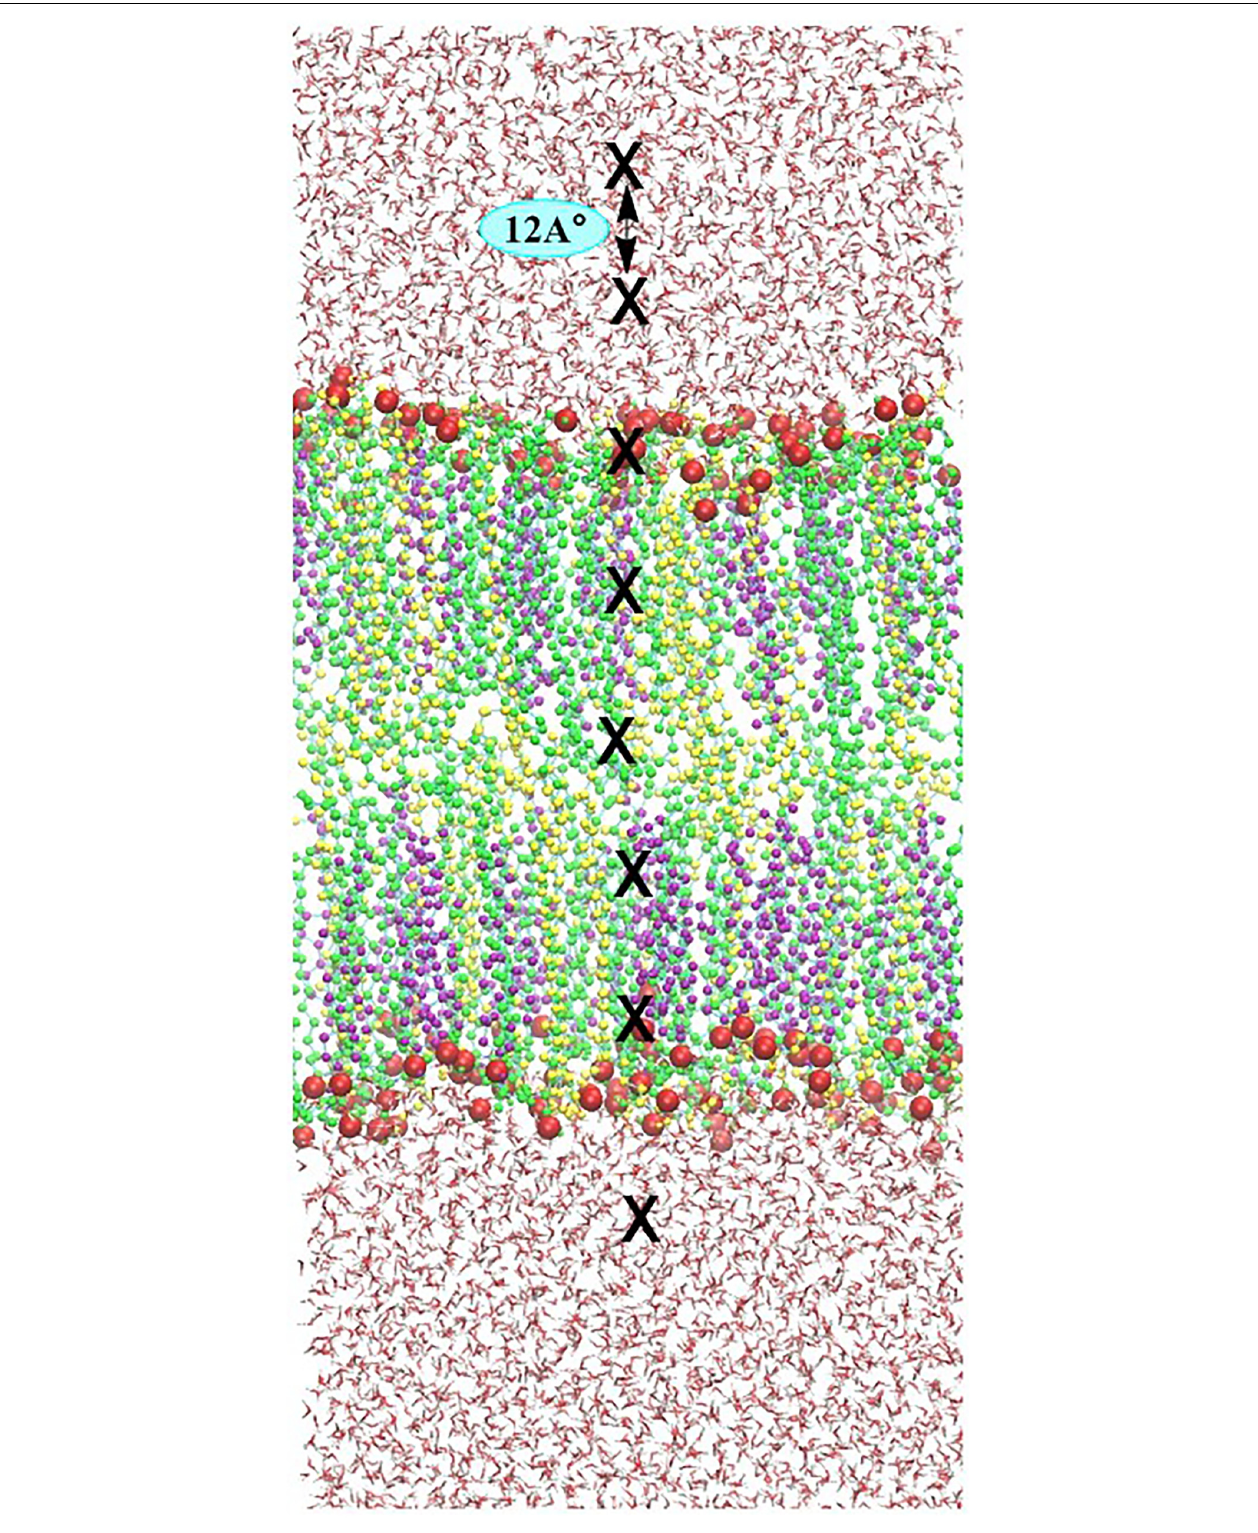
FIGURE 3 | Illustration of the umbrella sampling (US) simulation set-up. Eight umbrella windows separated by 12 Å (position of ROS depicted by block crosses) are sampled in one simulation. In consecutive simulations, each species is shifted by 0.12 Å. To sample the entire membrane system, 33 simulations are performed, yielding a total of 264 umbrella histograms from which a potential mean of forces (PMF) is constructed.